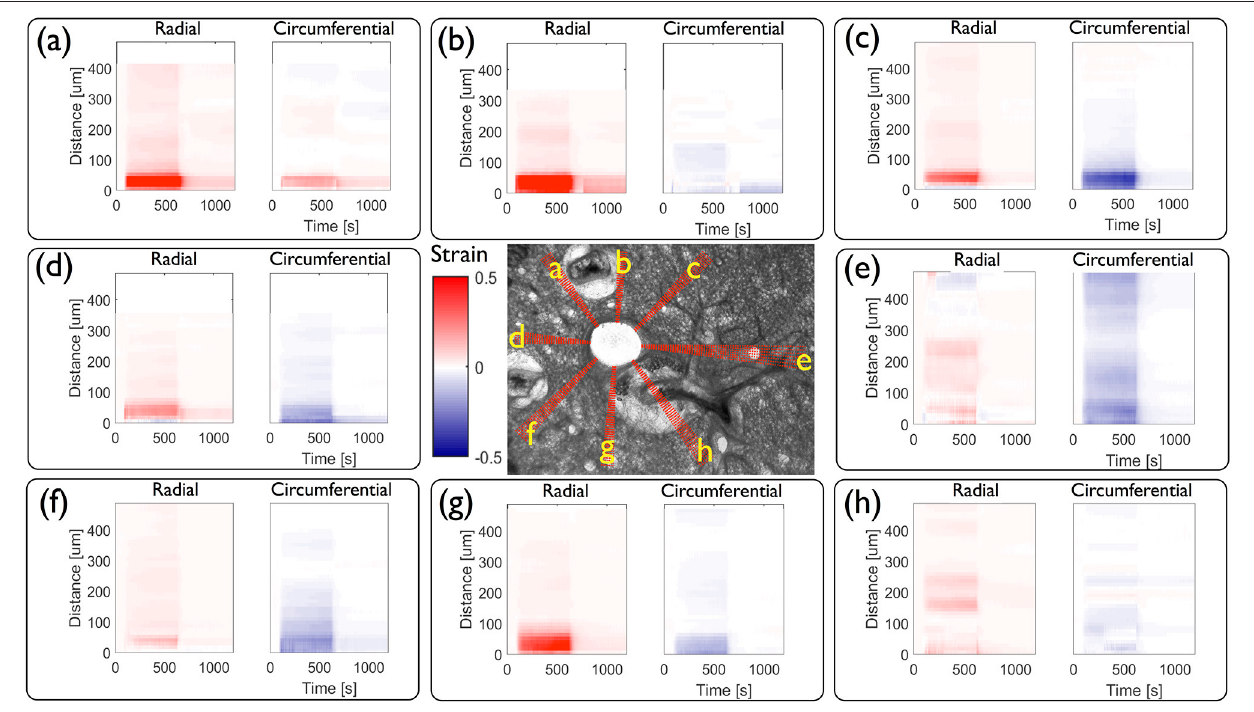
FIGURE 7 | Local quantitative analysis of a mouse lung slice (central image) from Figure 1 during agonist driven contraction. Radial and circumferential strain kymographs are plotted as a function of both time and distance from the airway lumen for each of the eight sets of independent spokes (a – h) shown on the central image. Spokes a , b , and g go through the highly collagenous part on the edge of a blood vessel; spokes c , d , and f go through alveolar tissue, spoke e intersects another small contractile airway and h goes through a blood